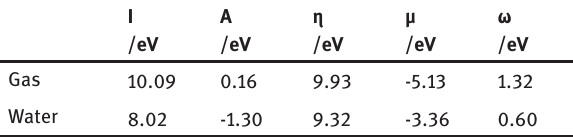
Table 2: Reactivity descriptors for quinclorac (conformer I) at the MP2/6-311++G(2d,2p)